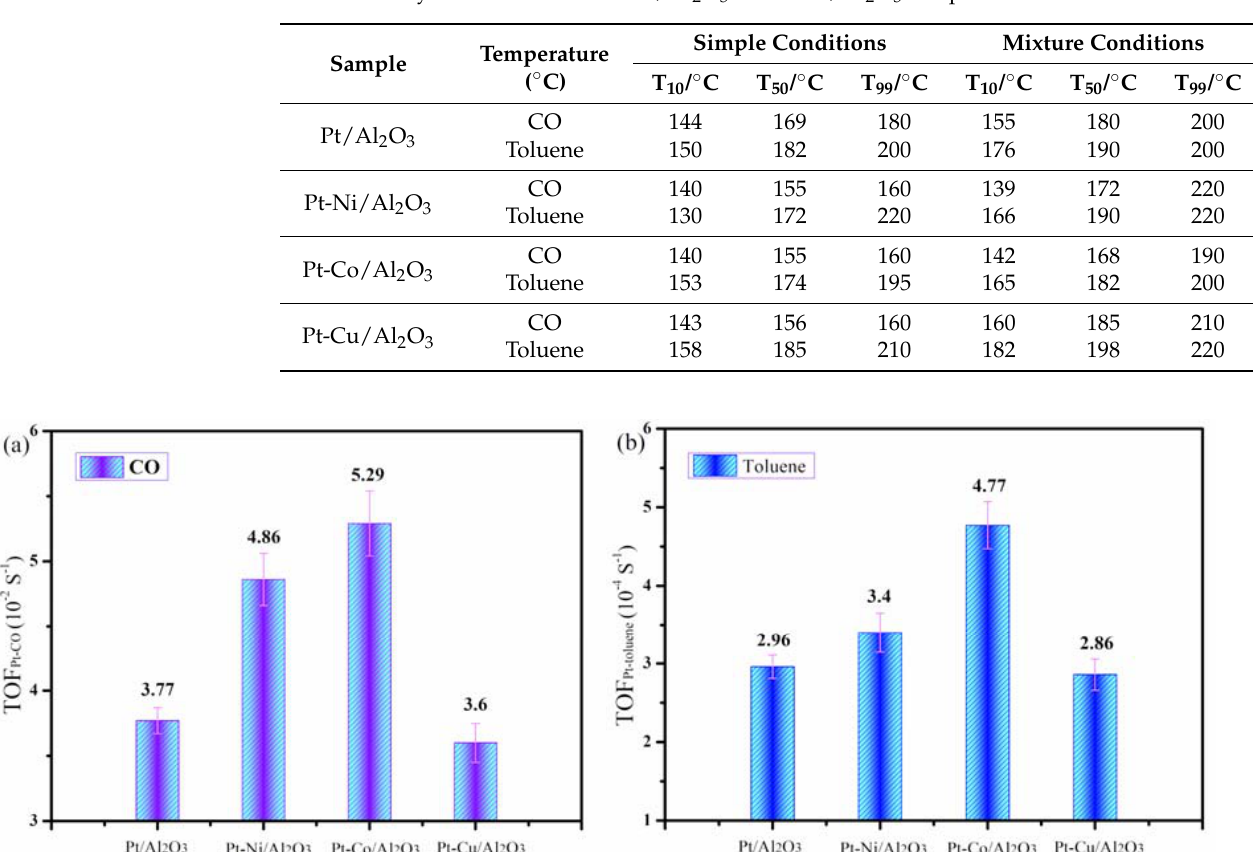
Table 3. Catalytic activities of these Pt/Al 2 O 3 and Pt-M/Al 2 O 3 samples under different conditions.